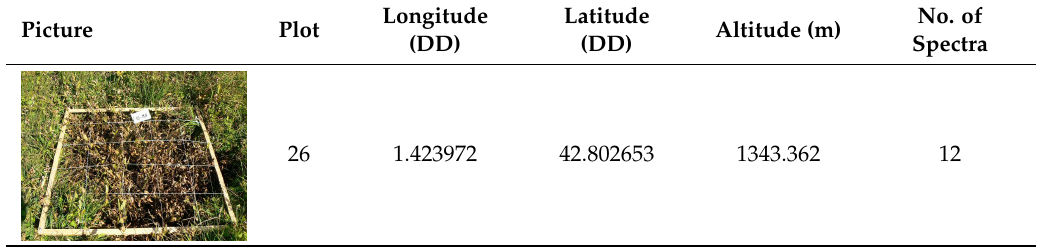
Table A12. Pictures, plots, geographic coordinates and number of spectra of Aquatic type c (AQ_C). Picture